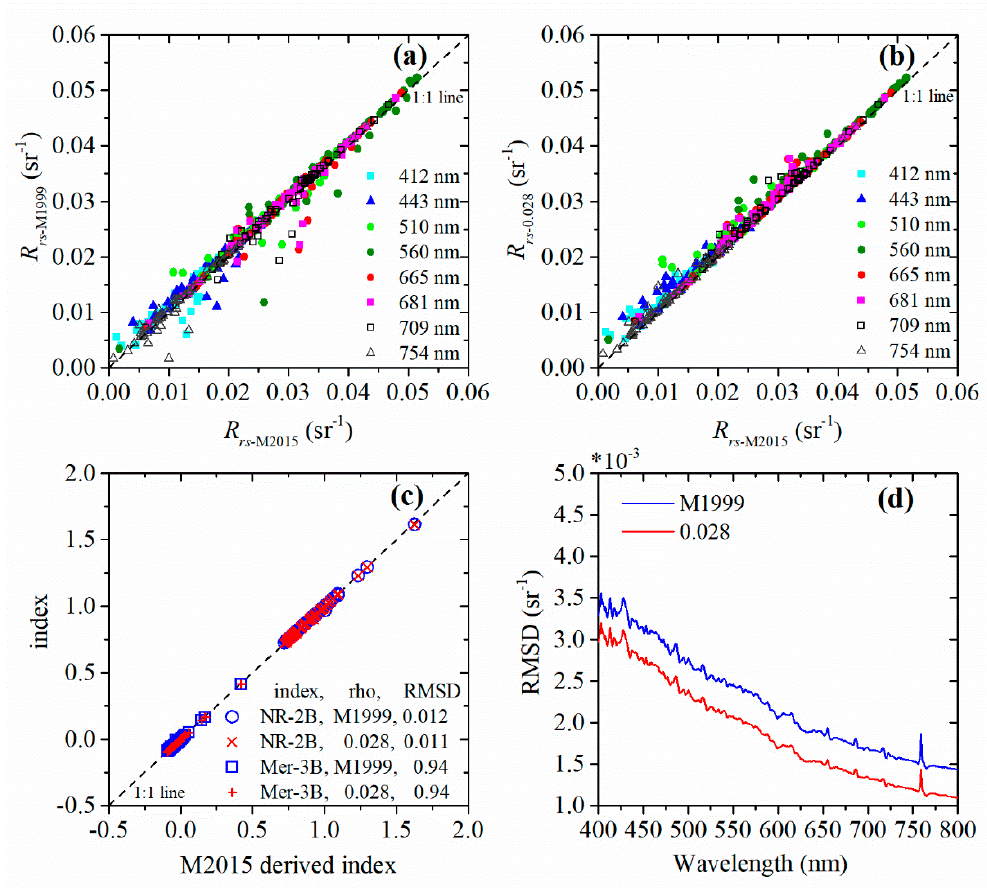
Figure 11. Comparison of R rs ( λ ) derived using ρ in Mobley (2015) [35] ( R rs -M2015 ( λ )) and ( a ) R rs ( λ ) derived using ρ in Mobley (1999) [34] ( R rs -M1999 ( λ )), and ( b ) using ρ = 0.028 for match-up pairs ( N = 63). ( c ) Comparisons between indexes (NR-2B, Mer-3B) derived using M2015 and M1999, 0.028, respectively. ( d ) Spectral RMSD of R rs ( λ ) between ρ of M2015 and M1999 (blue line), 0.028 (red line), respectively.